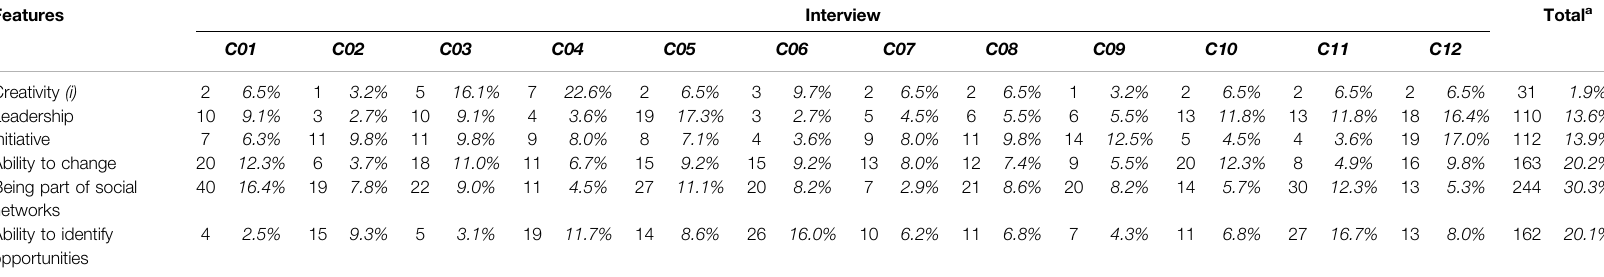
TABLE 6 | Innovative features quotes.